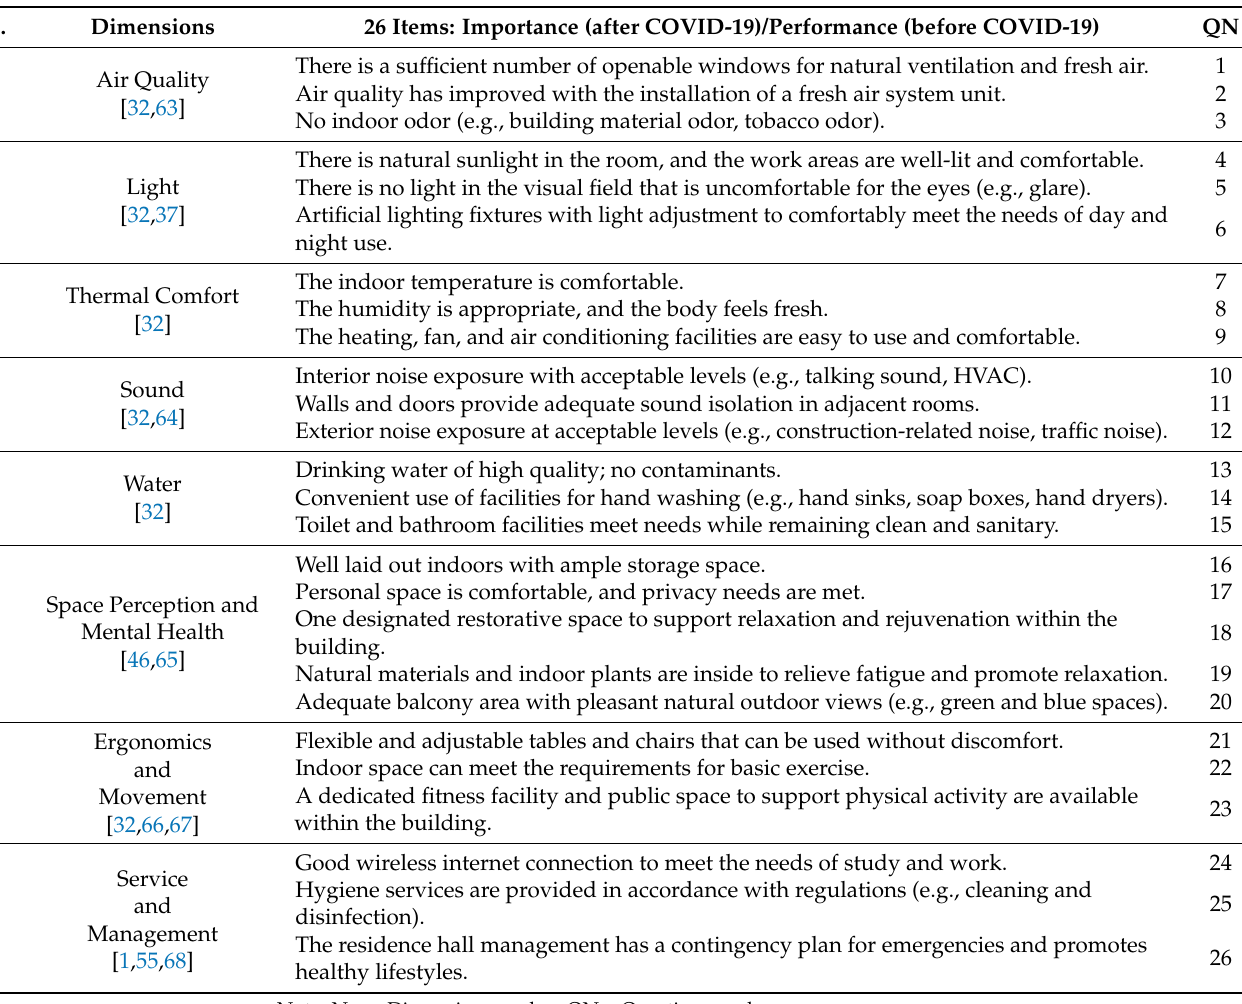
Table 1. The 26 items for measurement of healthy environments in university halls of residence before and after